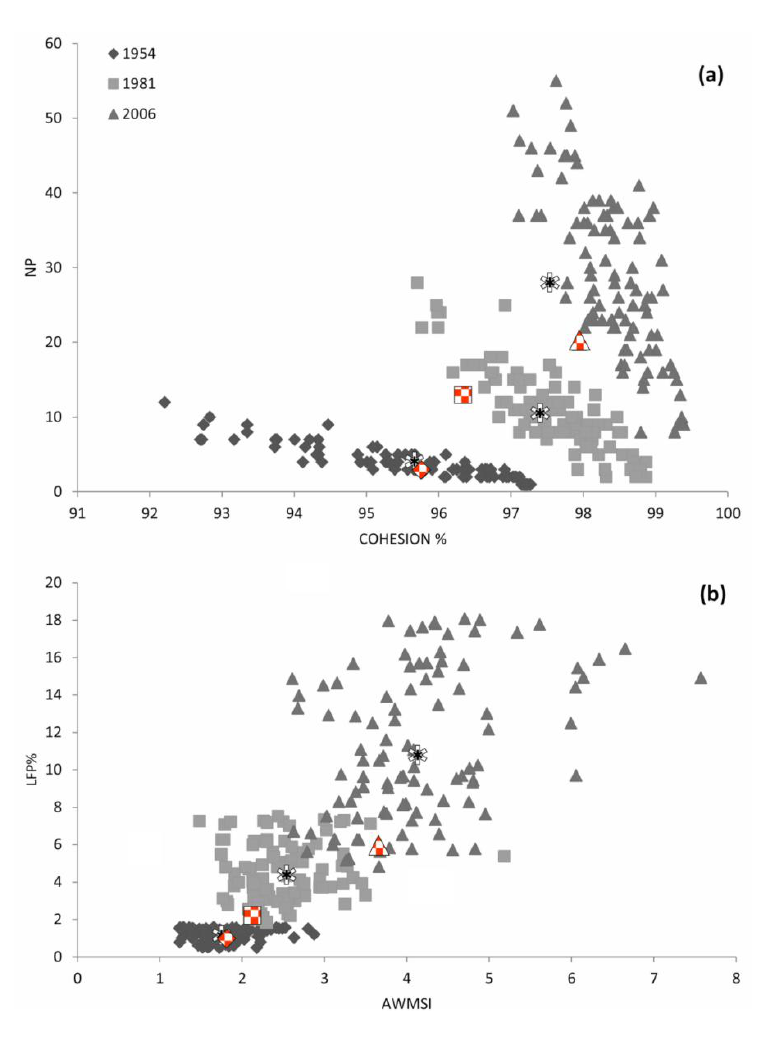
Figure 4. Scatter plots among two paired combinations of observed landscape pattern indices (LPI) values for simulated landscapes (N = 100; 1954, 1981 and 2006): ( a ) total number of patches of forest (NP) vs. COHESION and ( b ) LFP vs. weighted mean shape index (AWMSI). Asterisks indicate the mean values, and red symbols show the position of real landscapes within the empirical distribution derived from simulated landscapes (in grey